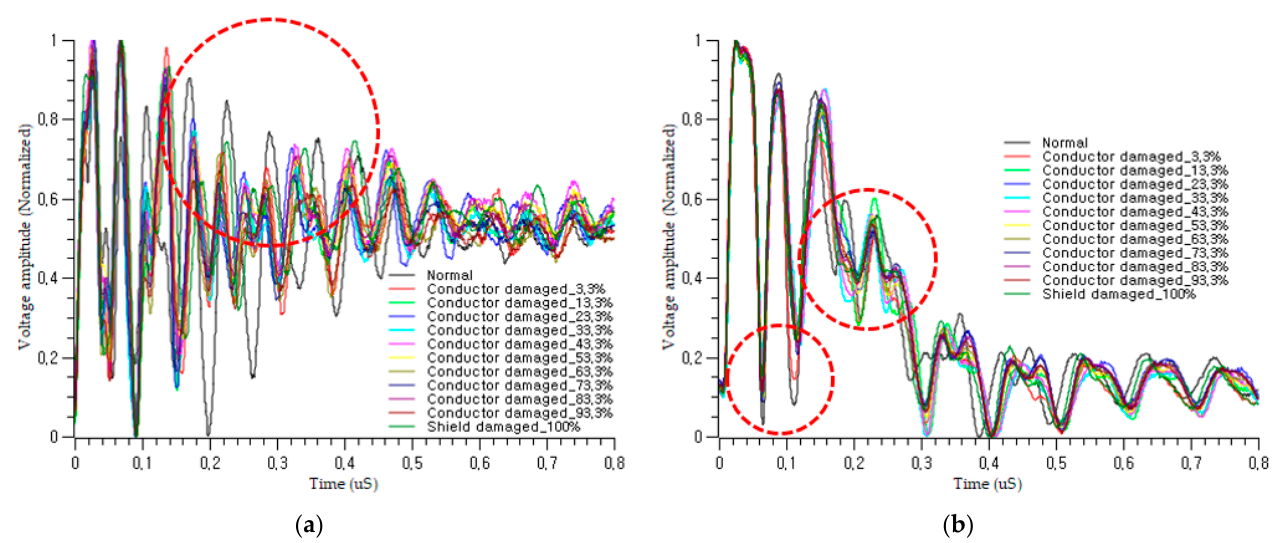
Figure 10. Transmitted signals through the faulty cable with various severity degrees of fault: ( a ) pulses detected online; ( b ) pulses detected offline.